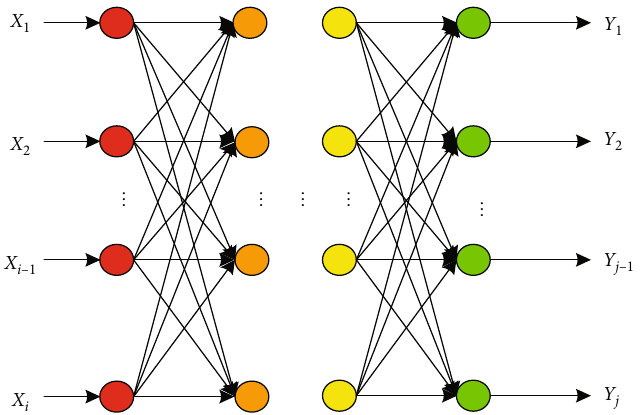
Figure 1: Schematic diagram of the structure of the BP neural network.